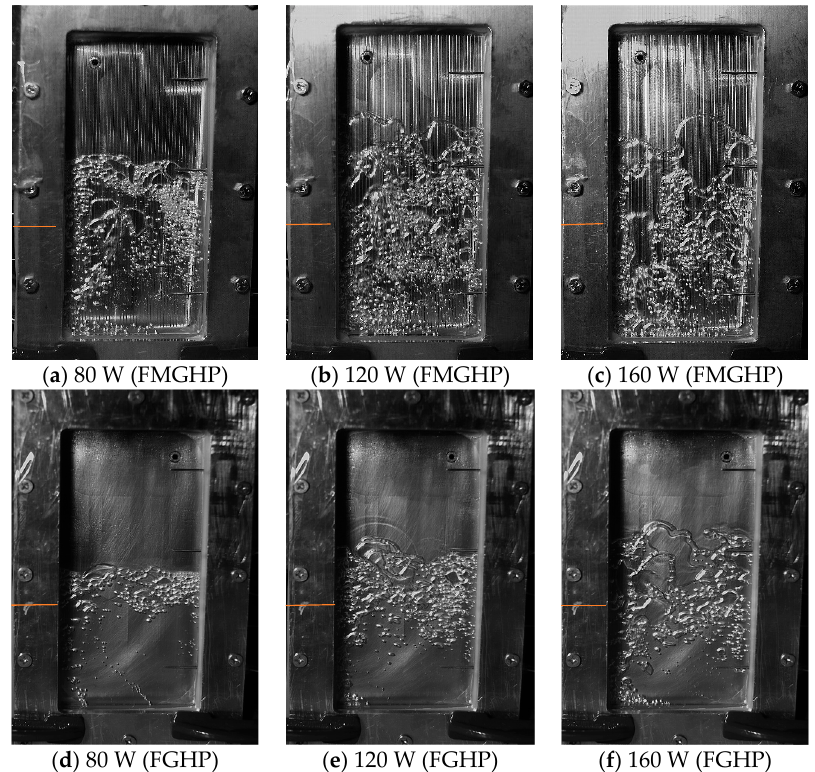
Figure 7. The liquid–vapor two-phase behaviors at 300 s of FMGHP 3 ( a – c ) and the FGHP ( d – f ) at different heating loads. Note: the initial liquid level is marked with the red line.